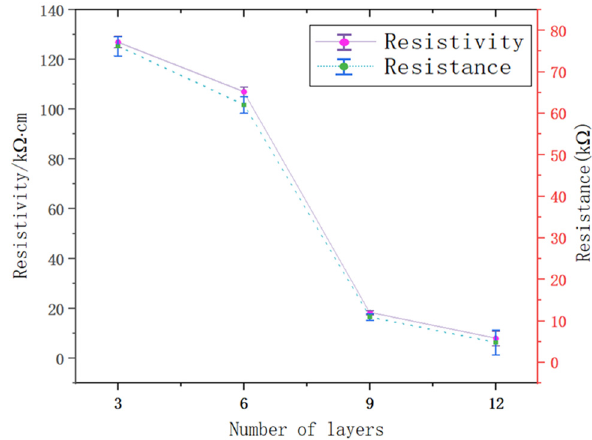
Figure 5: Relationship between the number of layers and resistance properties of CNTFS fl exible fi